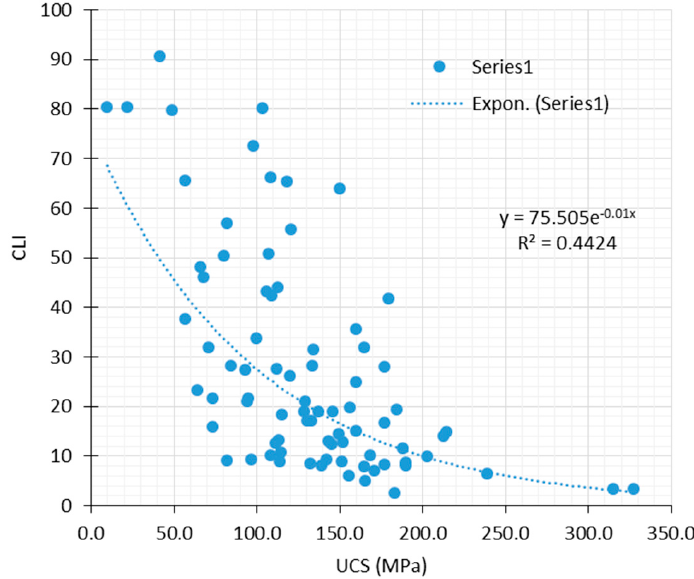
Figure 7. Relations between the UCS and CLI.